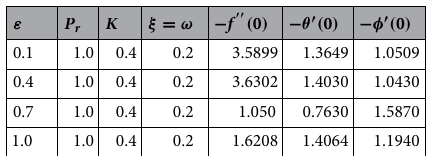
Table 2. Numerical values of reduced Nusselt numbers for various values of ε .